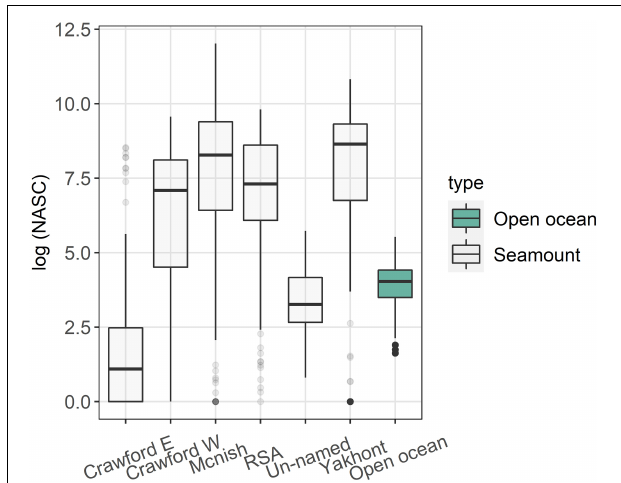
FIGURE 4 | Boxplot of the log-transformed Nautical Area Backscattering Coefficient (NASC), a proxy for biomass, calculated for the area above each of the seamounts and for the open ocean area. Lower and upper hinges correspond to the first and third quartiles. Dots at the end of the boxplot represent outliers.